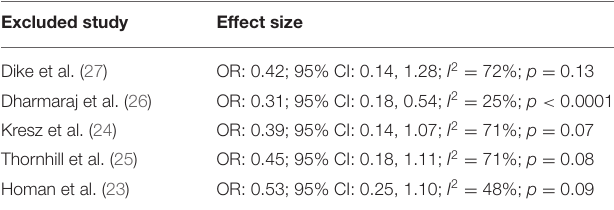
TABLE 2 | Results of sensitivity